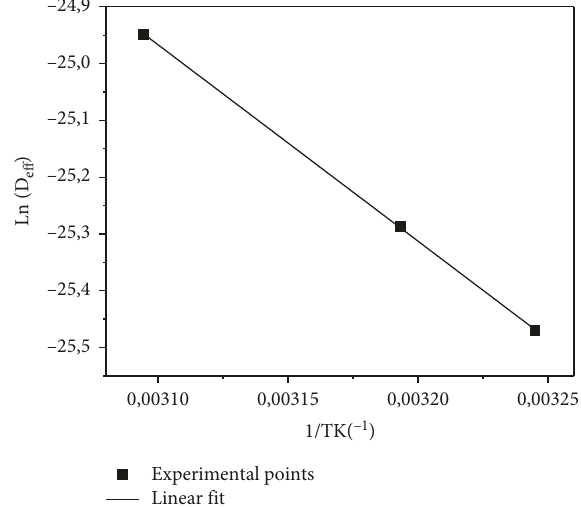
Figure 8: Influence of the drying air temperature on the effective moisture diffusivity of Crocus sativus L.